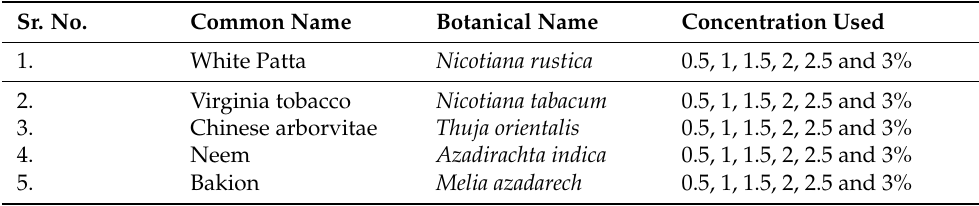
Table 2. Plant extract and their concentrations used against C. maculatus during 2021. Sr. No.